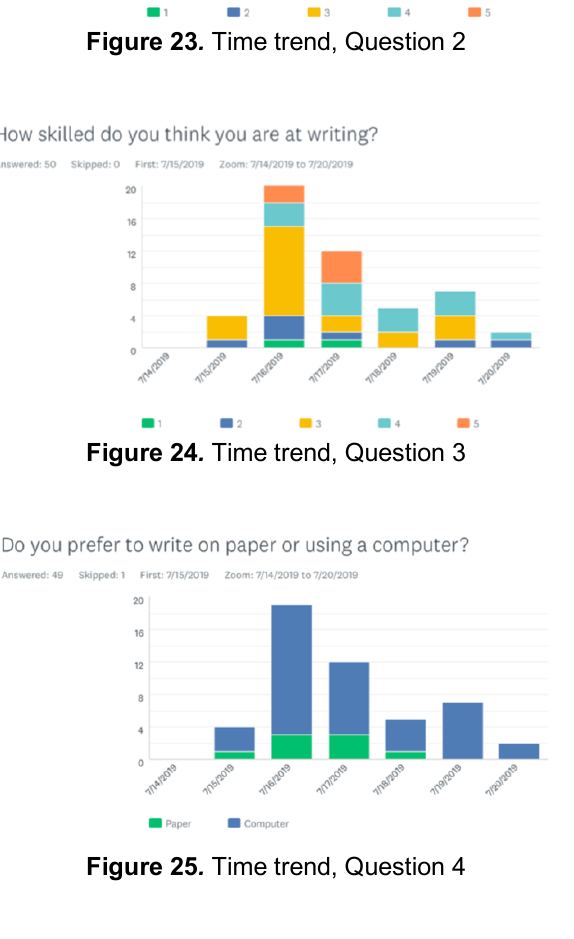
Figure 23 . Time trend, Question 2